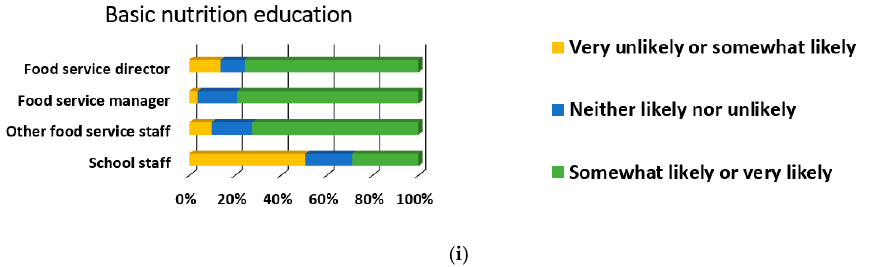
Figure 3. Nutrition training topic needs that significantly differed by participant role, n = 453 (food service director, n = 153; food service manager, n = 110; other food service staff, n = 62; school staff, n = 128). Described below for each panel are the χ 2 and p -values. ( a ) Meal pattern requirements, χ 2 (6) = 96.2, p < 0.001, Cramer’s V = 0.33; ( b ) Reimbursable meal requirements, χ 2 (6) = 61.6, p < 0.001, Cramer’s V = 0.26; ( c ) Portion sizes, χ 2 (6) = 98.1, p < 0.001, Cramer’s V = 0.33; ( d ) Local foods, χ 2 (6) = 66.3, p < 0.001, Cramer’s V = 0.27; ( e ) Smart Snacks, χ 2 (6) = 56.9, p < 0.001, Cramer’s V = 0.25;( f ) USDA foods, χ 2 (6) = 88.2, p < 0.001, Cramer’s V = 0.31; ( g ) Special dietary needs, χ 2 (6) = 90.4, p < 0.001, Cramer’s V = 0.32; ( h ) USDA Team